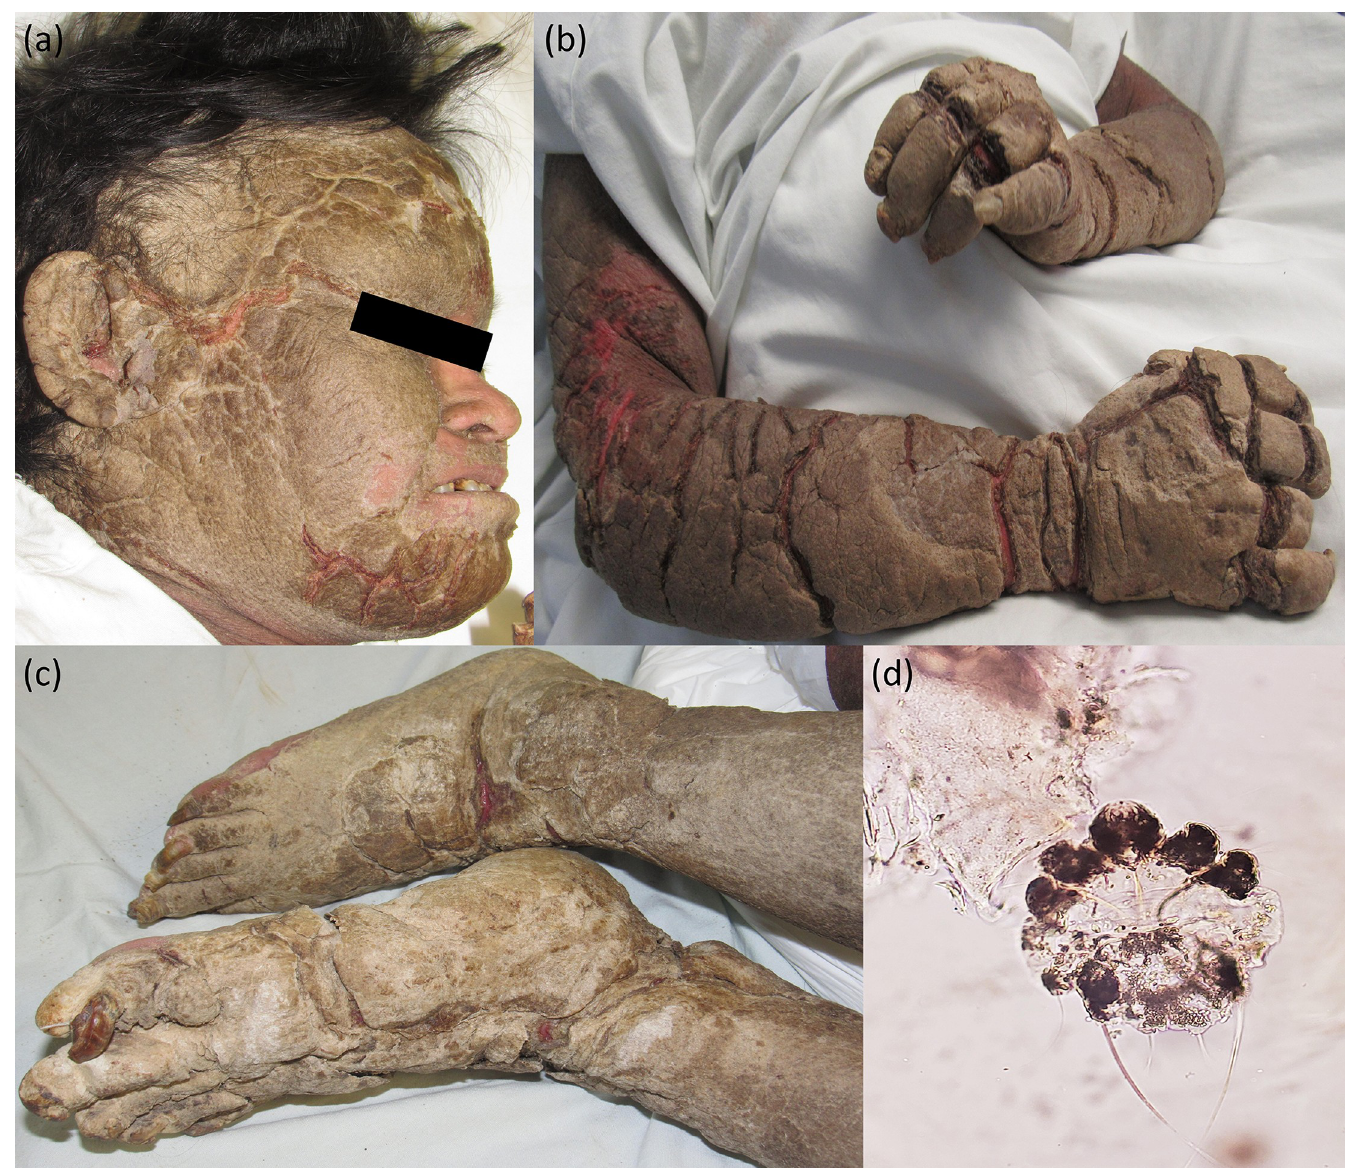
Fig 1. Neglected, hyperkeratotic, and generalized presentation of CS. (A) Face, (B) upper extremities, and (C) lower extremities with thick brown crusts divided by deep fissures with an erythematous background. (D) S . scabiei mite from a hand skin scraping. Original magnification × 400. CS, crusted